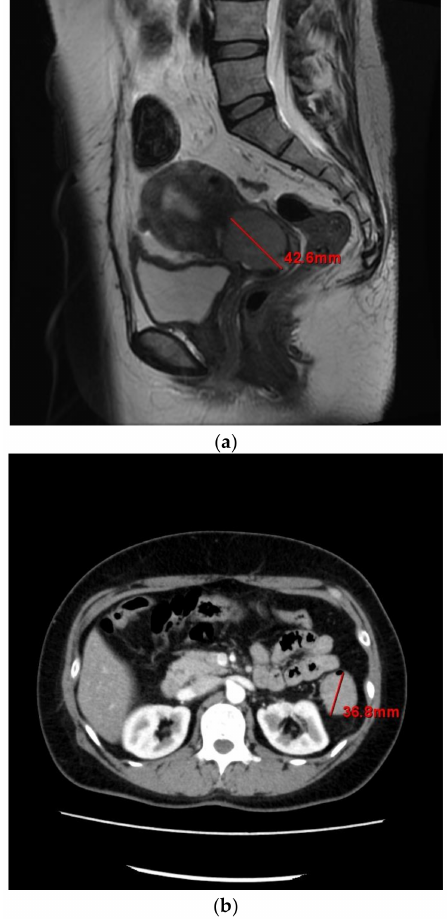
Figure 1. ( a ) Pelvic magnetic resonance imaging of the tumor in the endocervix; ( b ) Contrast-enhanced computed tomography of the abdomen showing the transverse colon